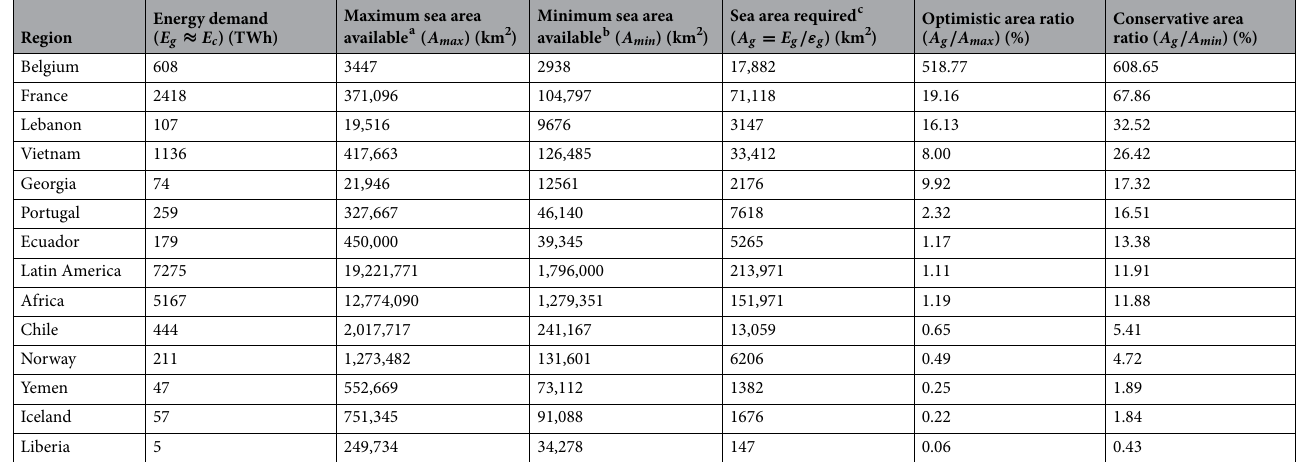
Table 13. Defined 100% offshore wind scenario according to the 2020 energy use for the different handpicked countries or regions based on an offshore wind annual energy density ( ε g ) of 0.034 TWh/km 2 (mean value of the offshore wind population in Table 11). The required sea area is calculated with Eq. (6) and compared relatively to the upper and lower estimates of the available sea area. a Optimistic estimate of the available sea area ( A max ), in the exclusive economic zone (EEZ), up to 370 km off the coastline. b Conservative estimate of the available sea area ( A min ), defined as a 50-km ocean corridor from 10 to 60 km off the coastline. c Sea area that must be regulated for offshore wind technology to meet 100% of the energy demand.